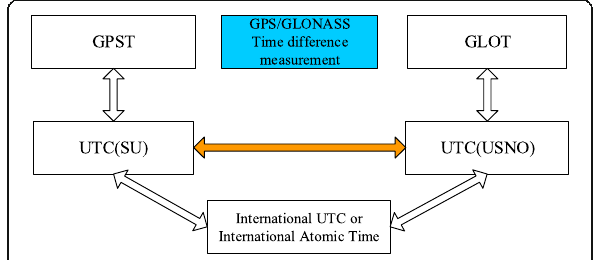
Fig. 1 Acquisition of time difference through GPS/GLONASS system time